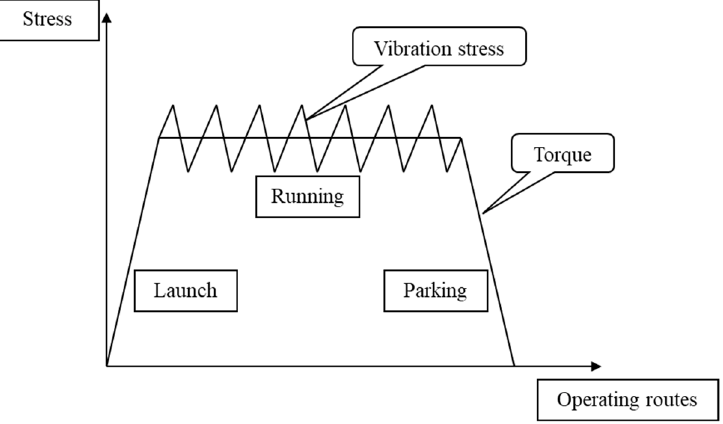
Figure 12. Boom force analysis per station.